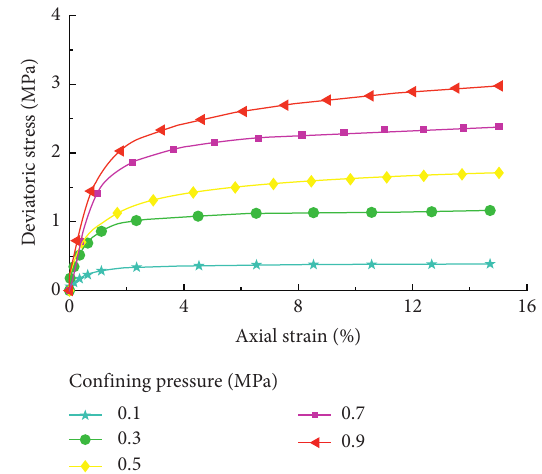
Figure 4: Influence of confining pressure on the stress-strain behavior of natural soils (compaction degree � 100; water content �